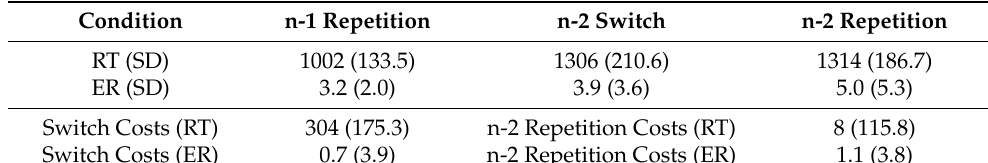
Table 3. Descriptive Values for mean reaction times (RT) in ms (SD) and error rates (ER) in percent (SD) for three conditions.